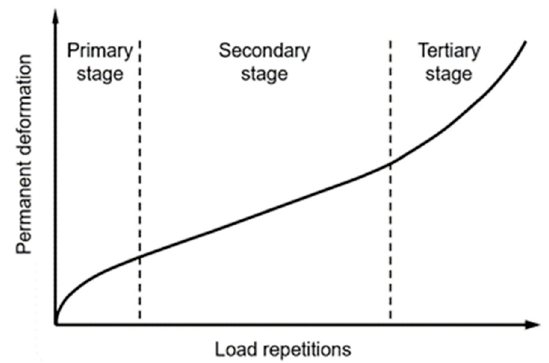
Figure 1. Typical rut progression curve of the asphalt concrete course.